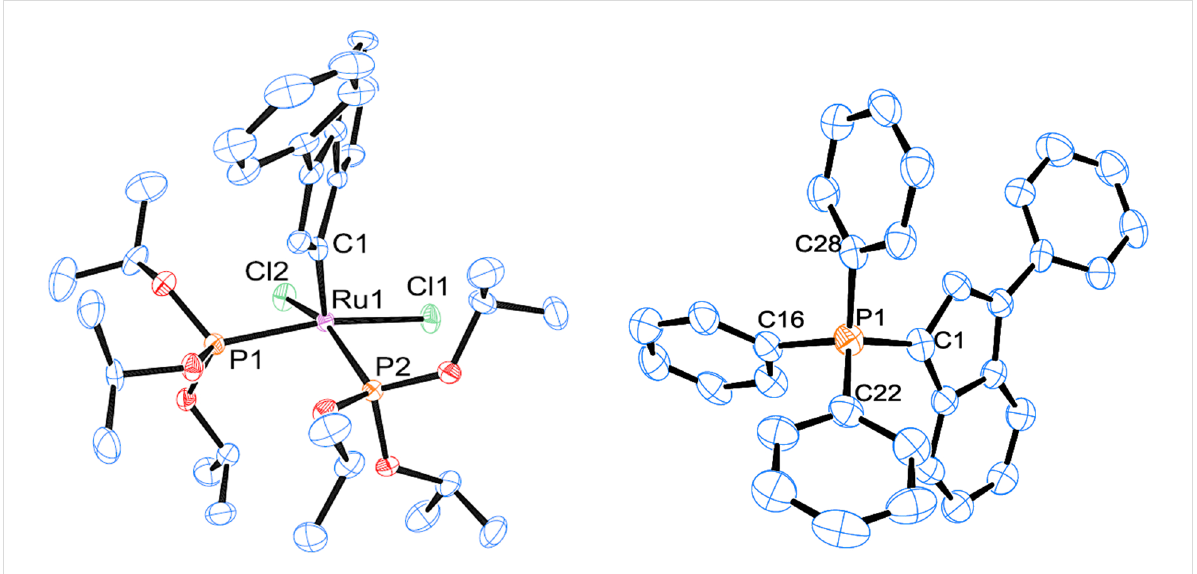
Figure 3: Molecular structure of 2 and the ylide 3 . Hydrogen atoms and solvent molecules are omitted for clarity. Selected bond distances (Å) and angles (°) (ESD) for compound 3 : P(1)–C(1), 1.713(5); P(1)–C(28), 1.795(5); P(1)–C(22), 1.805(5); P(1)–C(16), 1.811(5); C(1)–P(1)–C(28), 106.2(2);